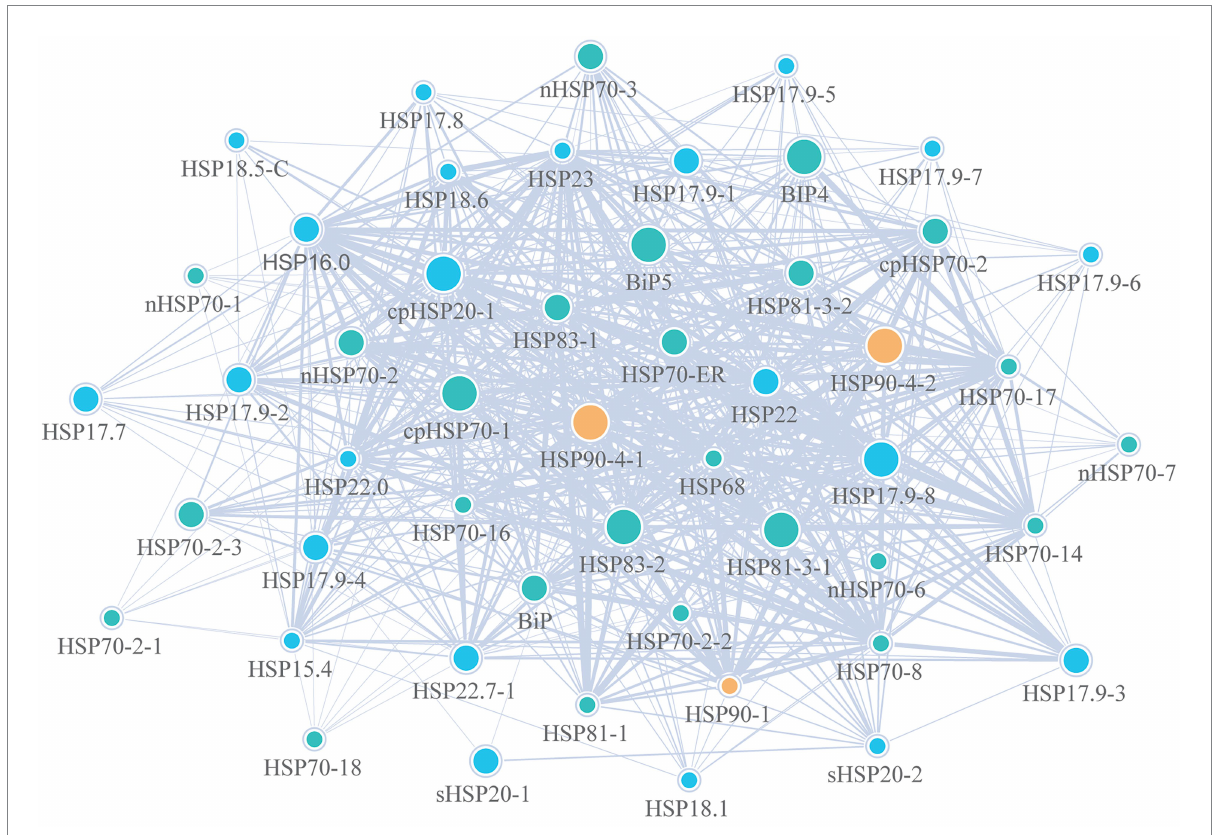
FIGURE 8 Protein–protein interaction (PPI) networks of Hsp20, Hsp70 and Hsp90 proteins in Dendrobium officinale . Blue, green and orange circles represent Hsp20, Hsp70 and Hsp90 proteins, respectively. The gradient circle size indicates the different degrees of